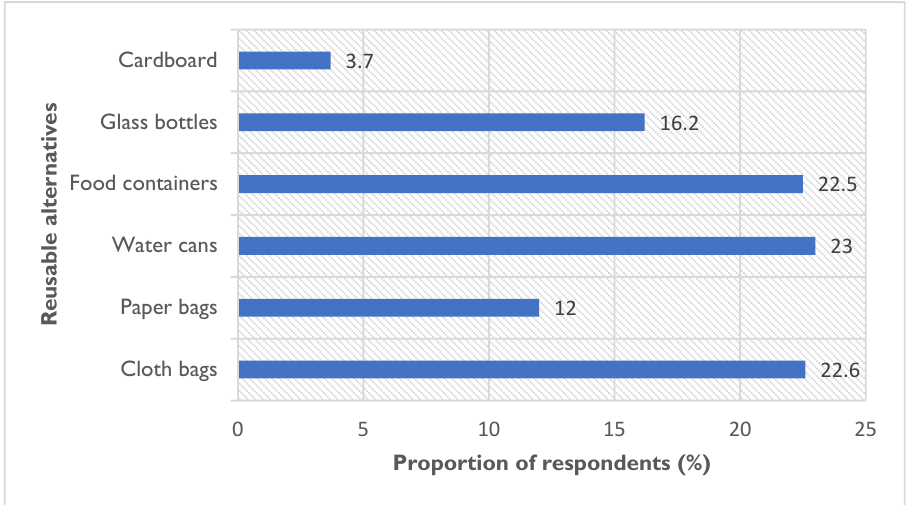
Figure 2. Distribution of respondents by reusable alternatives.